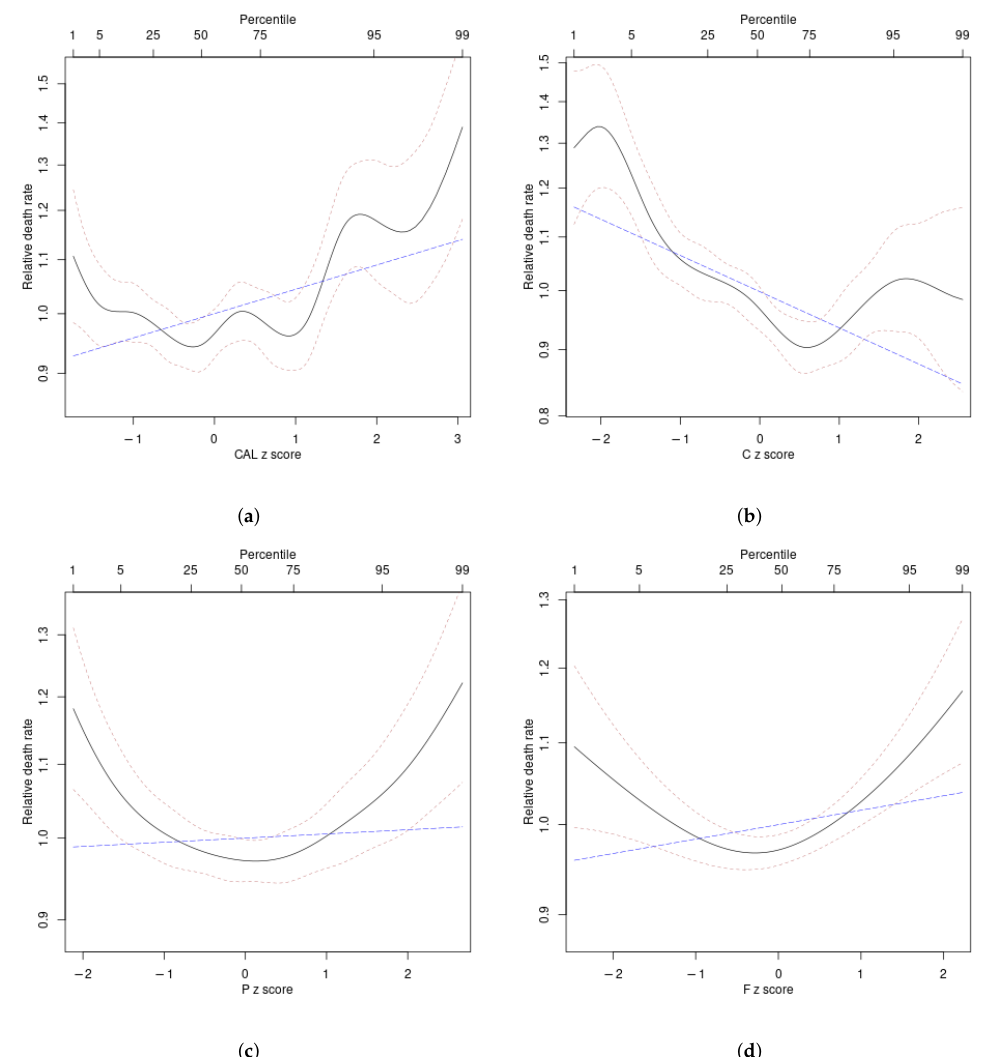
Figure 2. Estimated mortality hazard ratios in ARIC as nonlinear (penalized spline) functions of curves indicate 95% confidence intervals. The blue long-dashed line shows the corresponding best linear fit, which can be seen in some cases to not capture well the underlying nonlinear